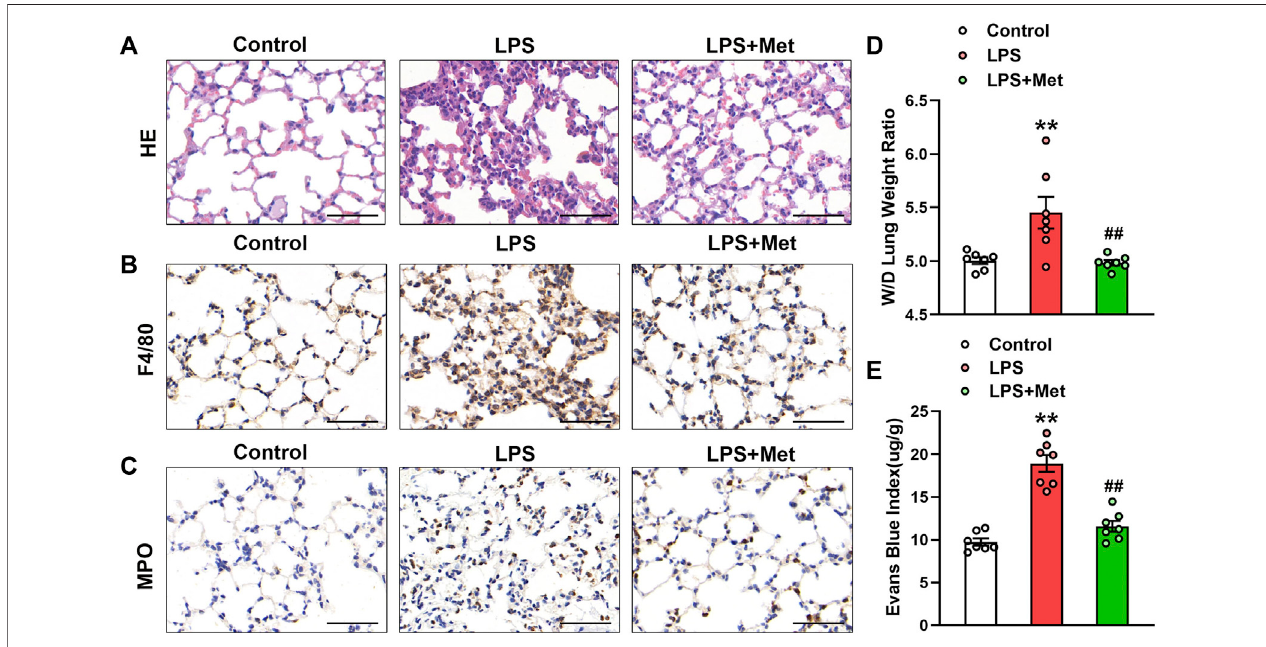
FIGURE 1 | Metformin ameliorates the morphological characteristics and vascular endothelial hyperpermeability of LPS-induced ALI in mice. Mice were subjected to LPS, with or without metformin treatment for 9 h. (A) Representative hematoxylin and eosin staining ofthe lung tissues. (B) Immunohistochemistry analysis was used to measure the intensity of F4/80. (C) Immunohistochemistry was used to measure the intensity of myeloperoxidase. (D and E) Lung W/D and Evans blue dye extravasation were determined as indexes of pulmonary edema. Original magni fi cation, ×200. Scale bar, 50 μ m. Data are presented as the mean ± SEM ( n = 7). ** p < 0.01 vs. Control group, ## p < 0.01 vs. LPS group. Myeloperoxidase,